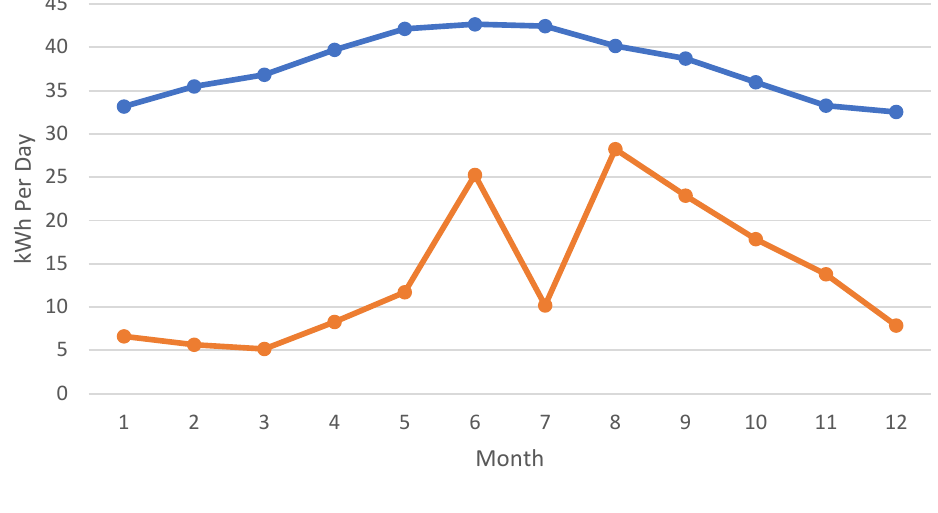
Figure 11. HPE vs. MPN (50% vs. 4 panels).